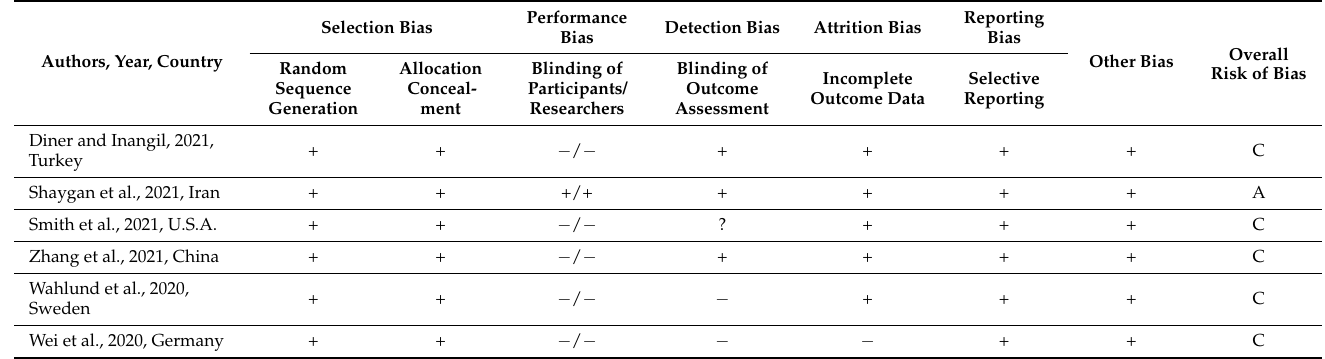
Table 2. Quality appraisal of all included